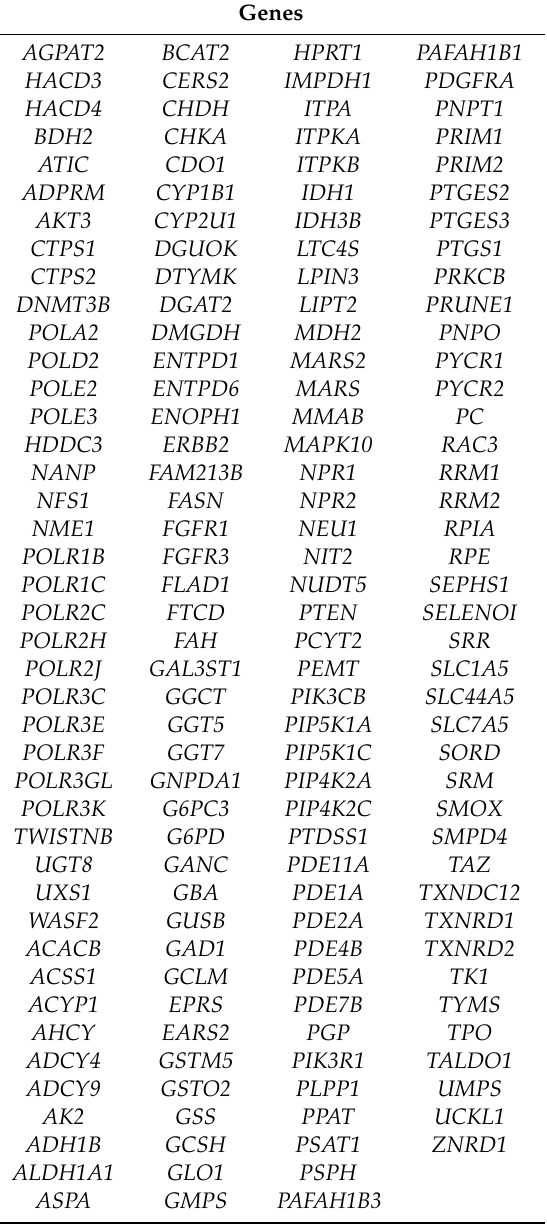
Table 9. Genes that have “metabolism” term in KEGG PATHWAY annotation in DAVID analysis. The total 166 genes were selected as metabolism-related genes in KEGG PATHWAY annotation as the result of DAVID analysis of the total 2815 probe set